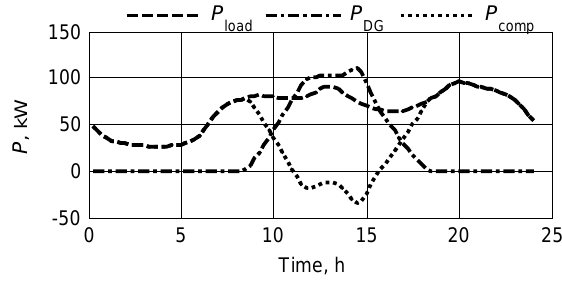
Fig. 6. Prediction curve for P load , P DG and the resulting P comp (scenario 1).